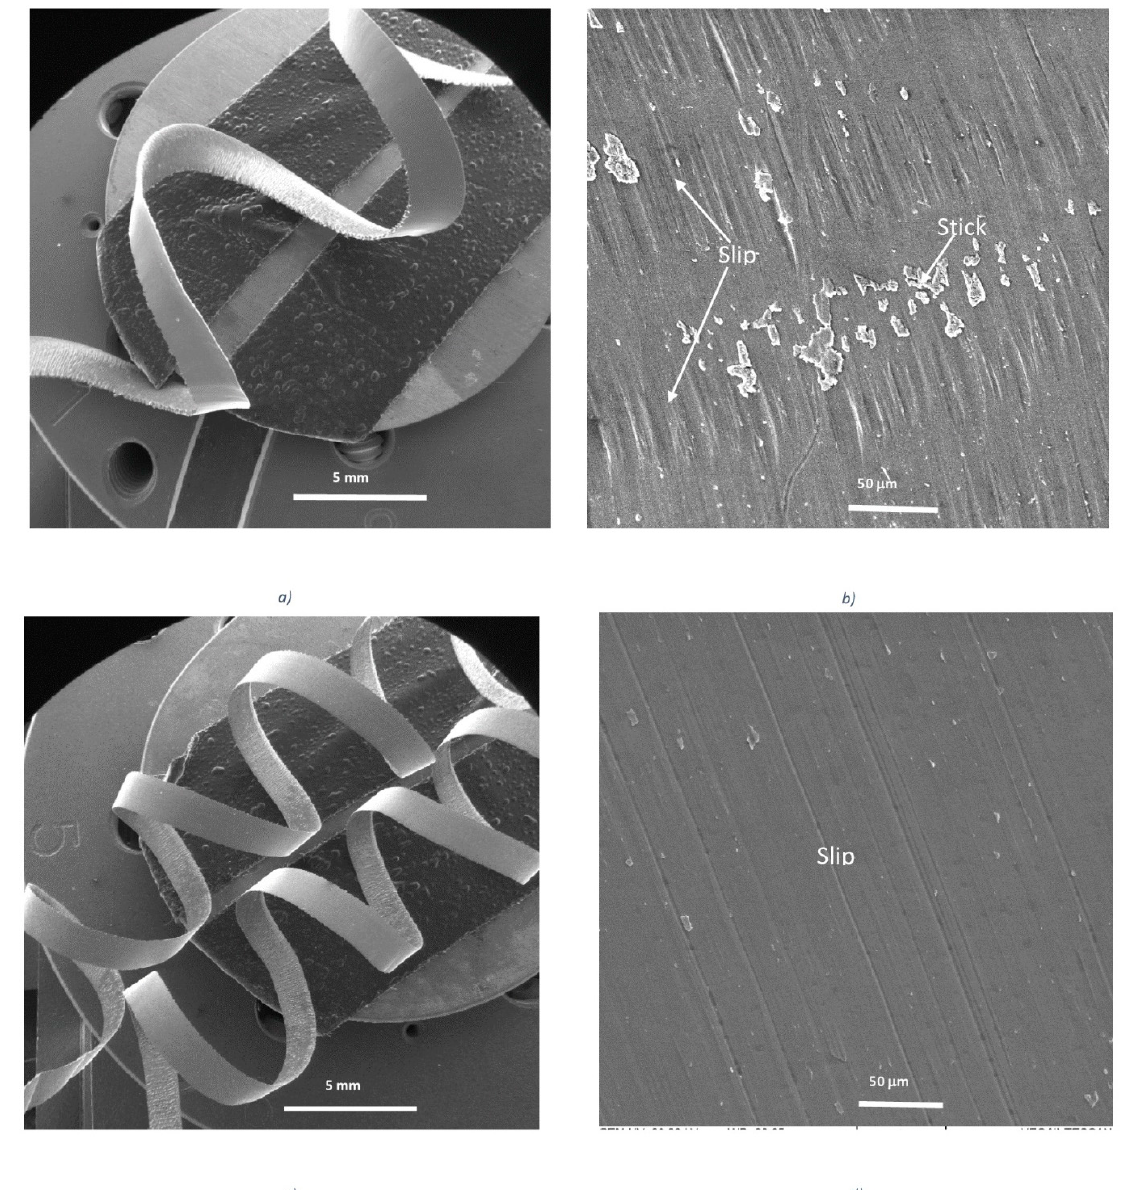
Figure 3. Type of chips and morphology of the chip undersurface for the ( a , b ) uncoated and ( c , d ) TiB2 coated cutting tools during rough turning of Ti6Al4V alloy. Reproduced from [28], with permission from Elsevier, 2017.